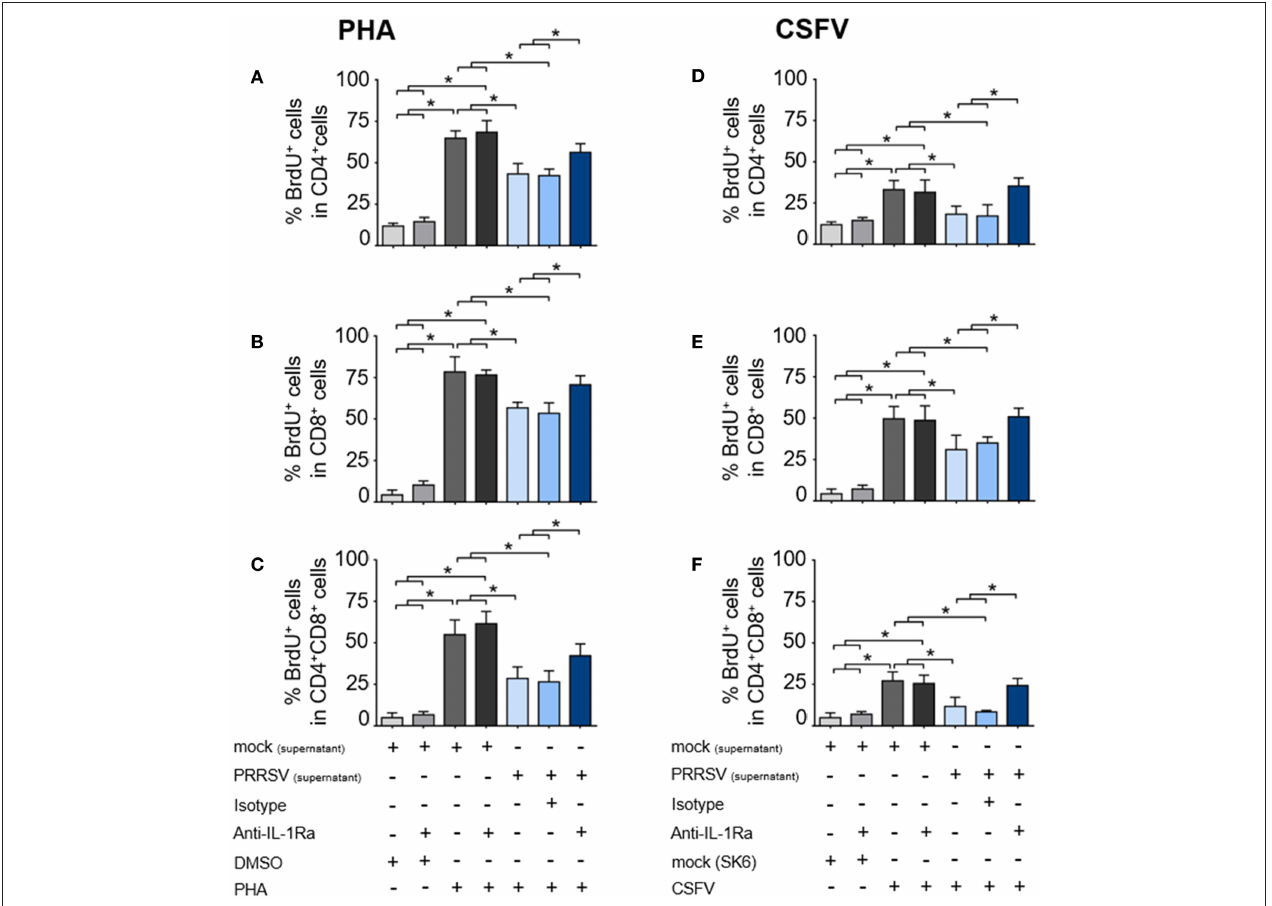
FIGURE 4 | PRRSV-induced IL-1Ra inhibited lymphocyte proliferation. PRRSV-induced IL-1Ra inhibited PHA-induced proliferation of the (A) CD4 + , (B) CD8 + , and (C) CD4 + CD8 + subpopulations. PRRSV-induced IL-1Ra inhibited CSFV-specific proliferations of the (D) CD4 + , (E) CD8 + , and (F) CD4 + CD8 + subpopulations. The supernatants obtained from type 2 PRRSV or mock (MARC-145 cell lysate) were pretreated with anti-IL-1Ra Ab for 2h prior to addition into the culture. PBL or PBMC were culture with PHA, CSFV or controls for 96h, in the presence of the pretreated supernatants. ± indicates presence/absence of indicated treatment within the culture. Data represents mean ± SD from 5 pigs. Statistical significance was analyzed using ANOVA followed by Tukey’s test. * indicates significant difference at p <